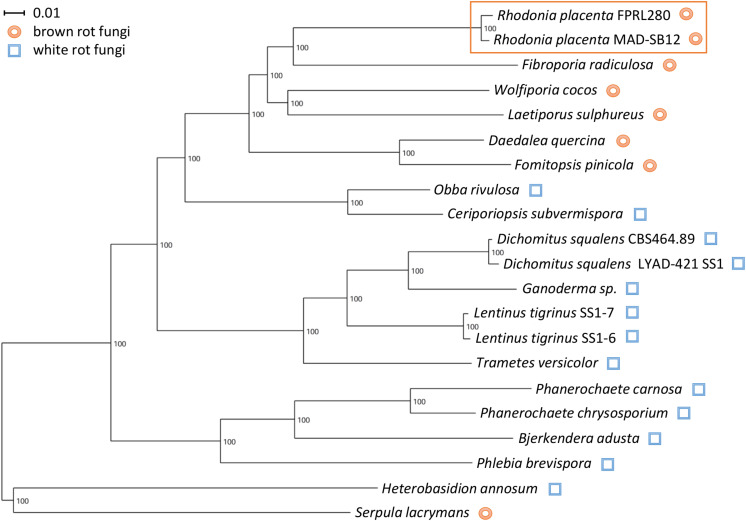
Phylogenetic tree of members of the order Polyporales based on 179 highly conserved proteins. S. lacrymans (order Russulales) and H. annosum (order Boletales) were used as outgroup to root the tree. The strains of R. placenta cluster closely together, as expected for closely related strains (orange box).